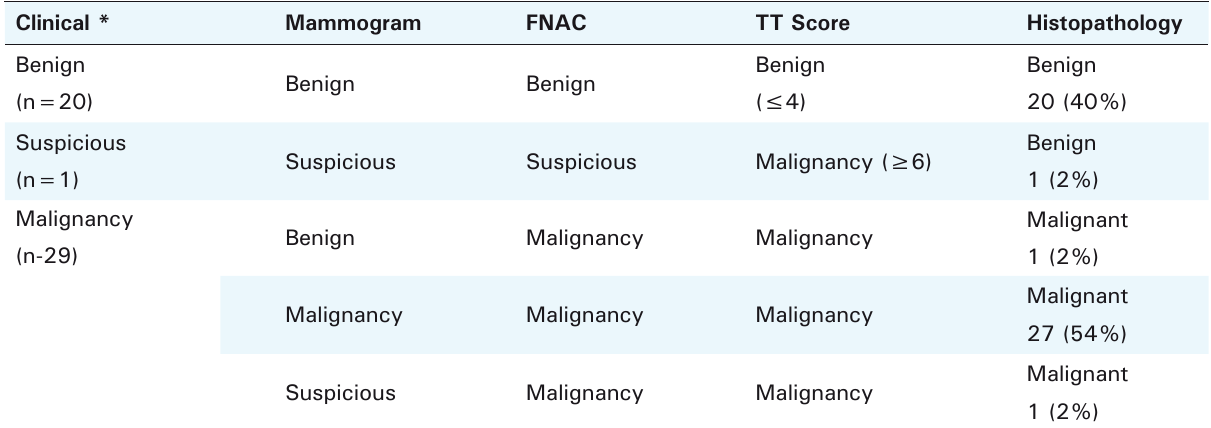
table 1. Correlation of all the components of t t Score and the histopathology Clinical